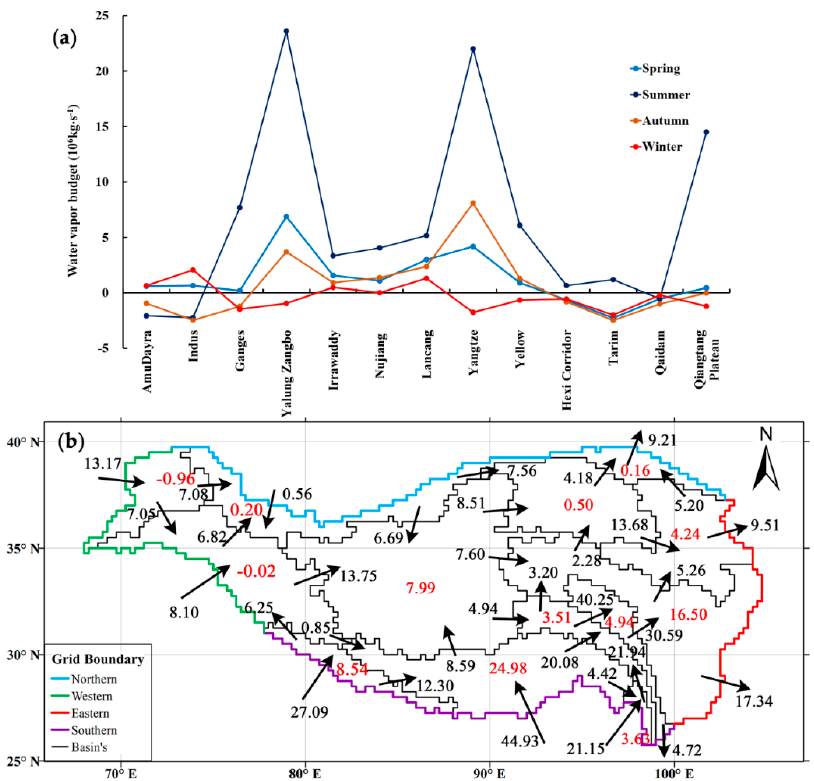
Figure 4. ( a ) Climatological mean WVBs in di ff erent seasons for the 13 basins; ( b ) summer climatological mean WVB of the basins and their boundaries for the TP (unit: 10 6 kg s − 1 ) from 1979 to